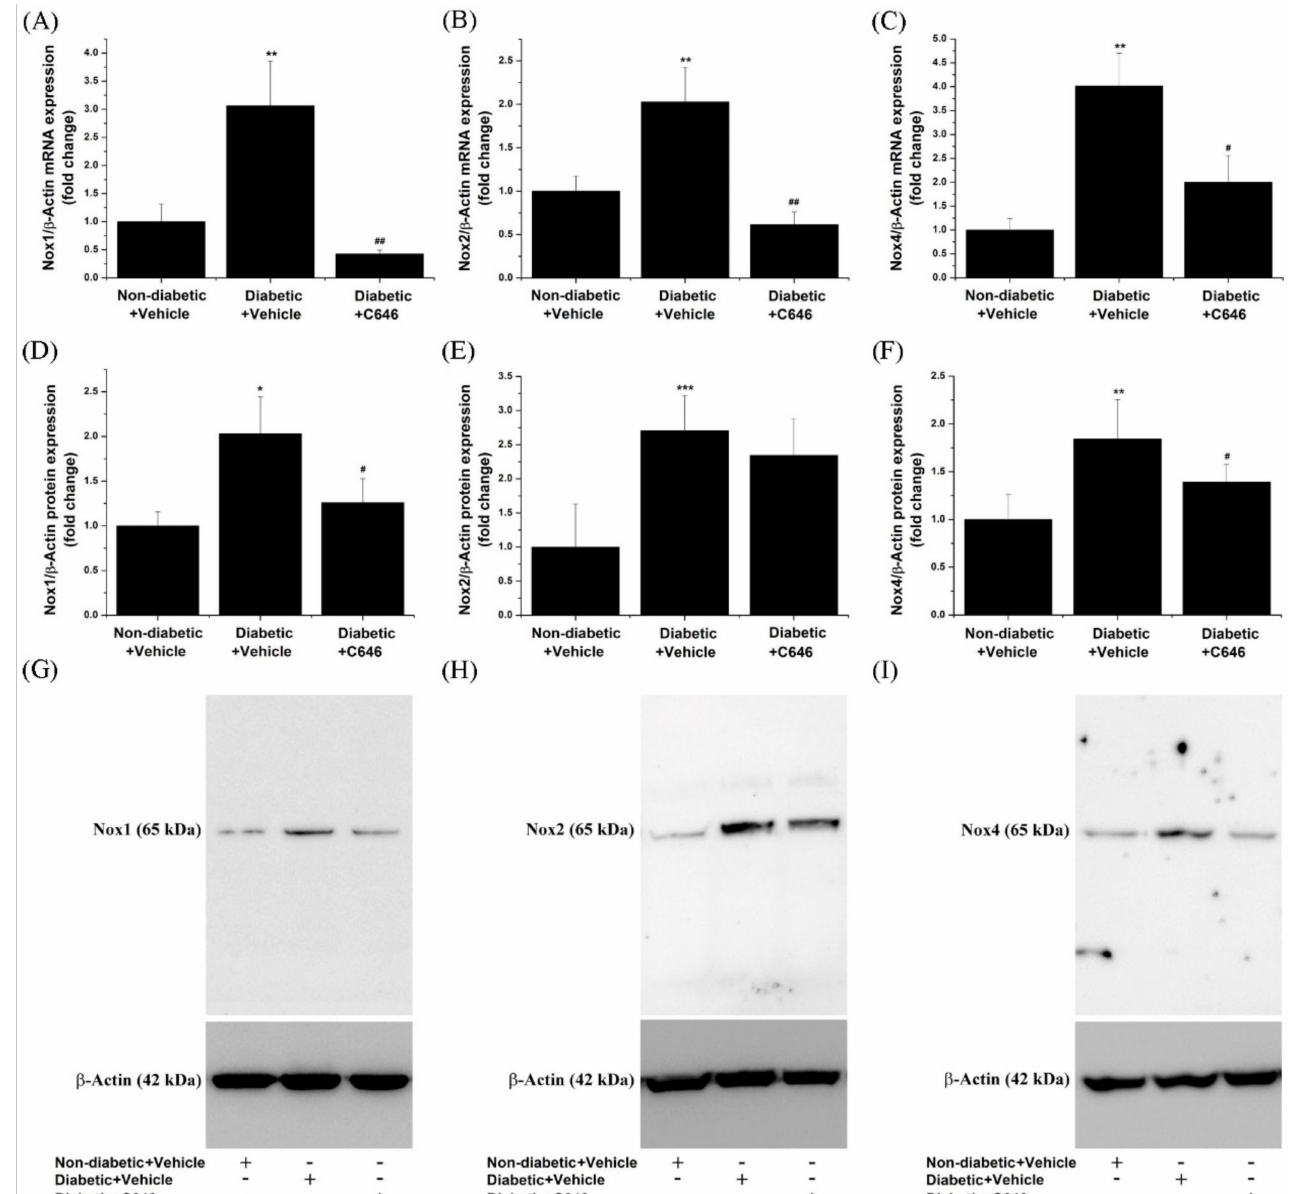
Figure 3. Histone acetyltransferase p300/CBP mediates the up-regulation of Nox expression in the kidney of diabetic mice. ( A – C ) Quantitative real-time PCR analysis indicating the suppressive effects of p300/CBP blockade on diabetes-induced enhanced mRNA levels of Nox1, Nox2, and Nox4 subtypes. ( D – F ) Densitometric analysis of the Western blot data showing the relative expression levels of Nox1, Nox2, and Nox4 proteins in each experimental condition. ( G – I ) Representative immunoblots depicting the modulation of Nox proteins expression. n = 3–4, * p < 0.05, ** p < 0.01, *** p < 0.001, p -values taken in relation to non-diabetic + vehicle condition; # p < 0.05, ## p < 0.01, p -values taken in relation to diabetic + vehicle